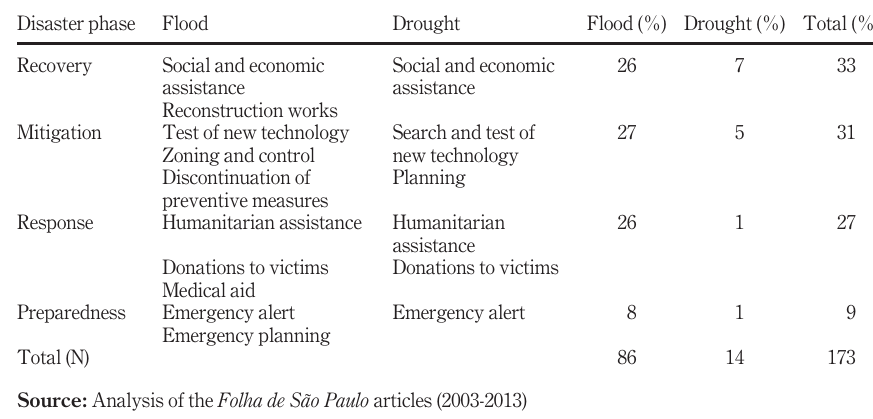
Table VII. Reported activities from fl oods and